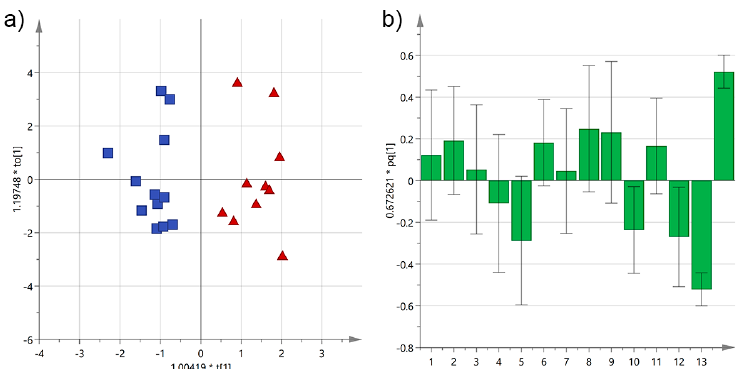
Figure 12. ( a ) OPLS-DA score plot for Ogliarola EVOO samples from Salento categorized by their proximity either to the Ionian Sea (red triangles), or to the central mainland (blue squares); ( b ) OPLS-DA loadings column plot for the first predictive component of the model (variables: 1 = total biophenols; 2 = hydroxytyrosol; 3 = tyrosol; 4 = 3,4-DHPEA-EDA; 5 = 3,4-DHPEA-EA; 6 = lignans; 7 = luteolin; 8 = p -HPEA-EDA; 9 = p -HPEA-EA; 10 = 3,4-DHPEA-EA in the mixed aldehydic and hydroxylic form; 11 = p -HPEA-EA in the mixed aldehydic and hydroxylic form; 12 = α -tocopherol; 13 = central mainland; 14 = Ionian area).